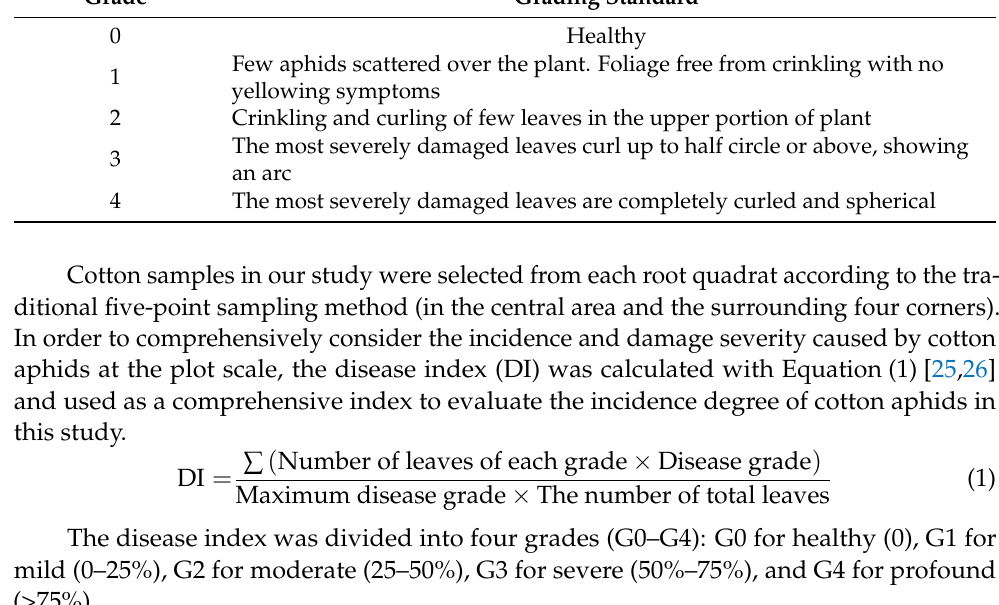
Table 1. The grading criteria for cotton aphid infestation. Grade Grading Standard 0 Healthy Few aphids scattered over the plant. Foliage free from crinkling with no 1 yellowing symptoms 2 Crinkling and curling of few leaves in the upper portion of plant The most severely damaged leaves curl up to half circle or above, showing 3 an arc 4 The most severely damaged leaves are completely curled and